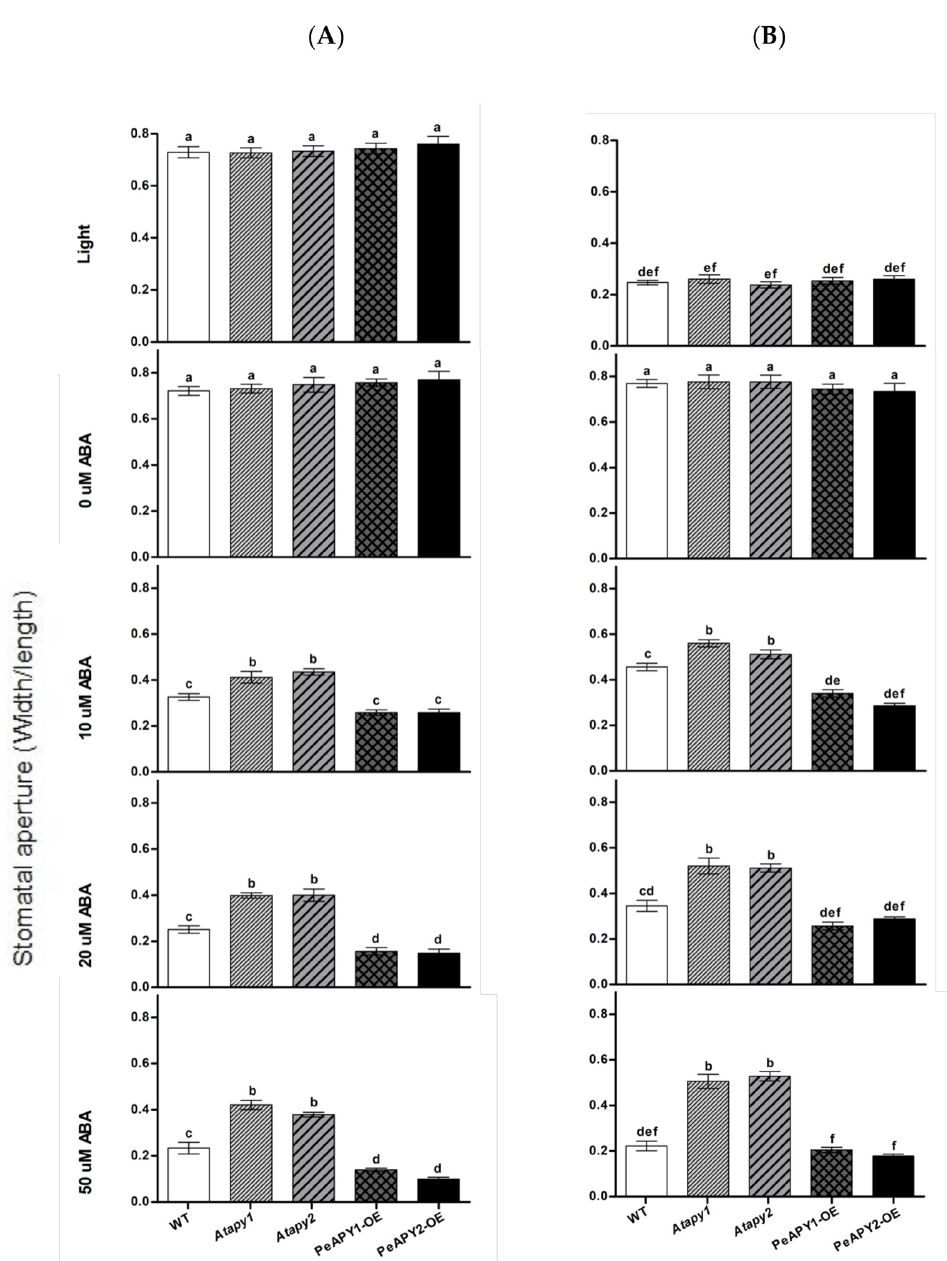
Figure 4. Effects of ABA on stomatal aperture in wild-type (WT), Arabidopsis loss-of-function mutants for APY1 and APY2 ( Atapy1 and Atapy2 ) and transgenic lines of PeAPY1 and PeAPY2 (PeAPY1-OE and PeAPY2-OE). Leaves from three-week-old seedlings were incubated in MES-Tris buffer (pH 6.15) for 2 h in light (150 µ mol m − 2 s − 1 ) ( A ) or in darkness ( B ). Thereafter, leaves were exposed to different concentrations of ABA (0, 10, 20 or 50 µ M) for 2 h in cool light (150 µ mol m − 2 s − 1 ). Stomatal aperture was measured in continuously illuminated leaves ( A ) and dark-adapted plants transferred to light ( B ), respectively. Each column is the mean of three independent experiments, and error bars represent SE. Columns labeled with different letters, a, b, c, d, e and f, showed a significant difference at p < 0.05 between treatments and genotypes under conditions of continuous light ( A ) or dark-adapted leaves transferred to light ( B